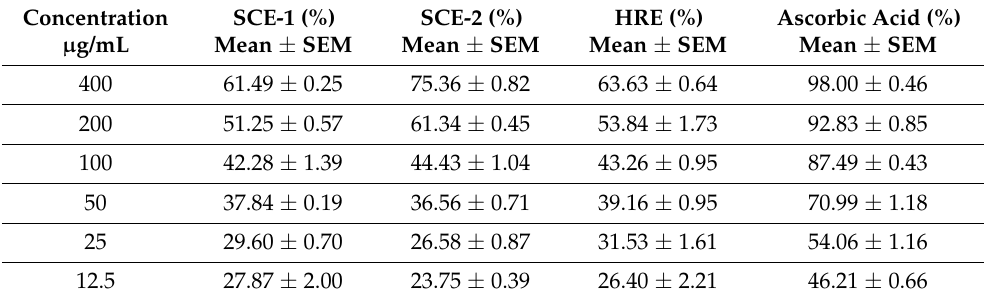
Table 1. DPPH scavenging activity of the experimental extracts.